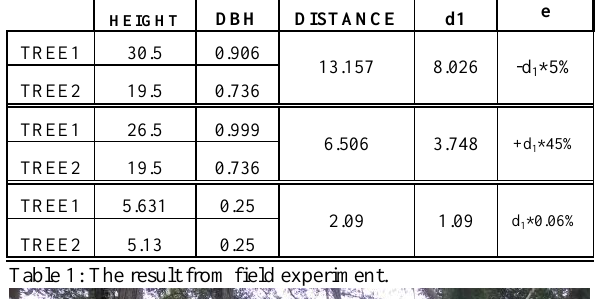
Table 1: The result from field experiment.